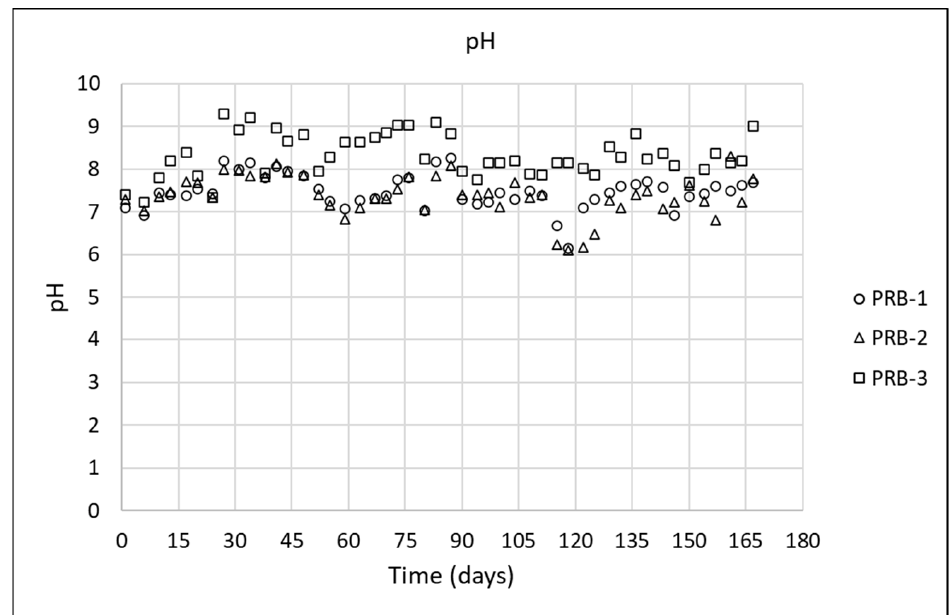
Figure 7. Changes in pH in PRB column reactors.